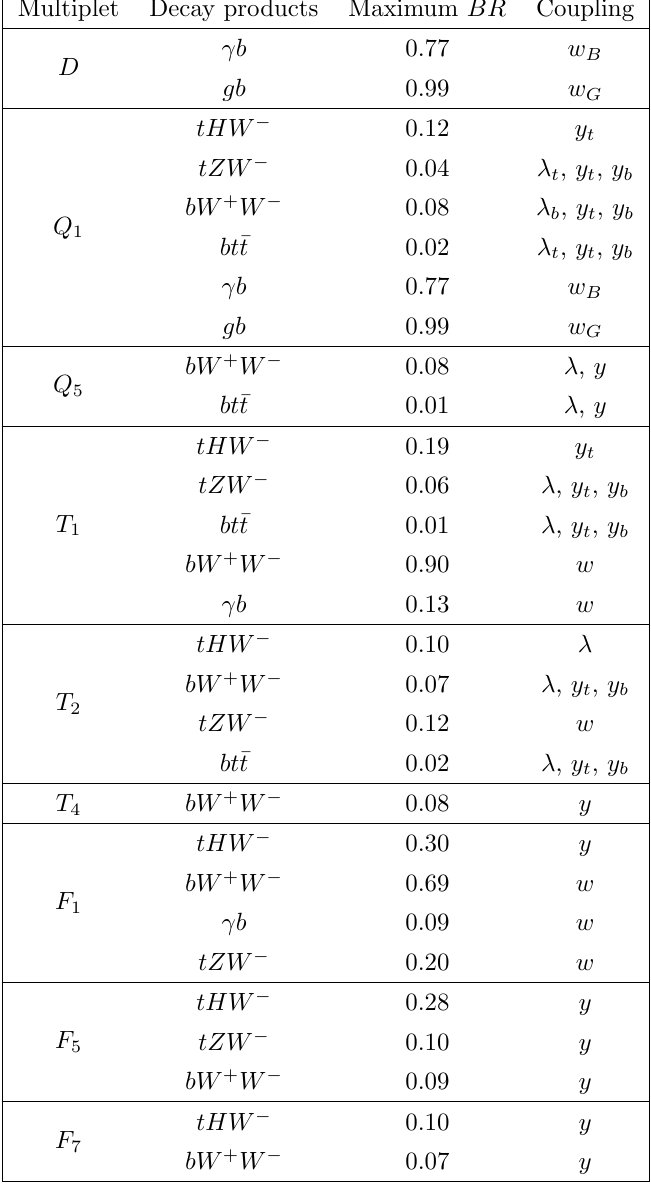
Table 9 . Extra decay channels of B with branching ratio larger than 0.01 for M = 2 TeV, when the couplings (cid:21) are (cid:12)xed to the values that saturate electroweak precision limits. The last column displays the coupling constant which, when set to (2 TeV) (cid:0) 1 , gives the maximum BR in the corre- sponding channel. The appearance of (cid:21) indicates that the channel in question is present already in the case with dimension-4 interactions only.